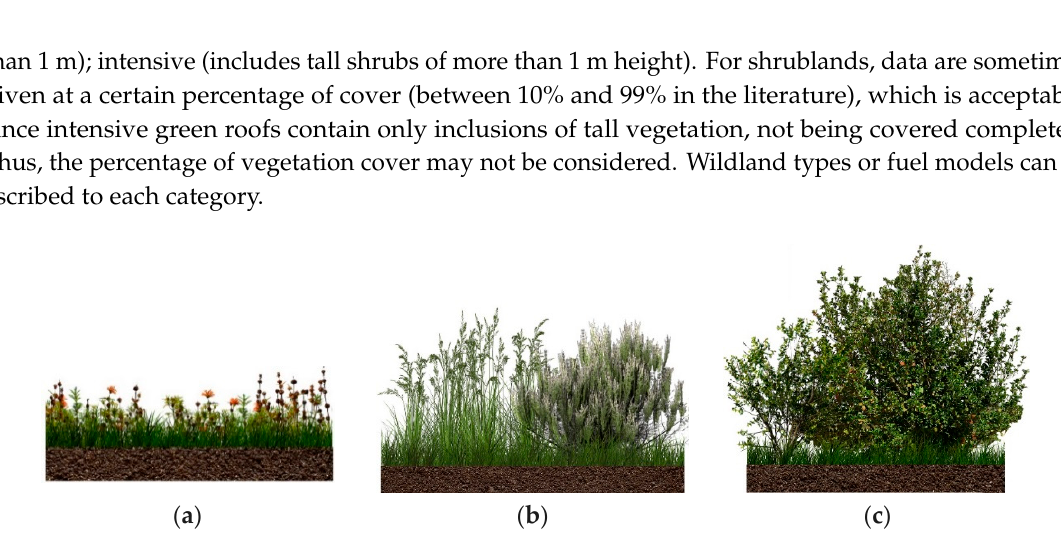
Figure 1. Green roof categories: ( a ) extensive (with low grass); ( b ) semi-intensive (with tall grass and low shrubs); ( c ) intensive (with tall shrubs).